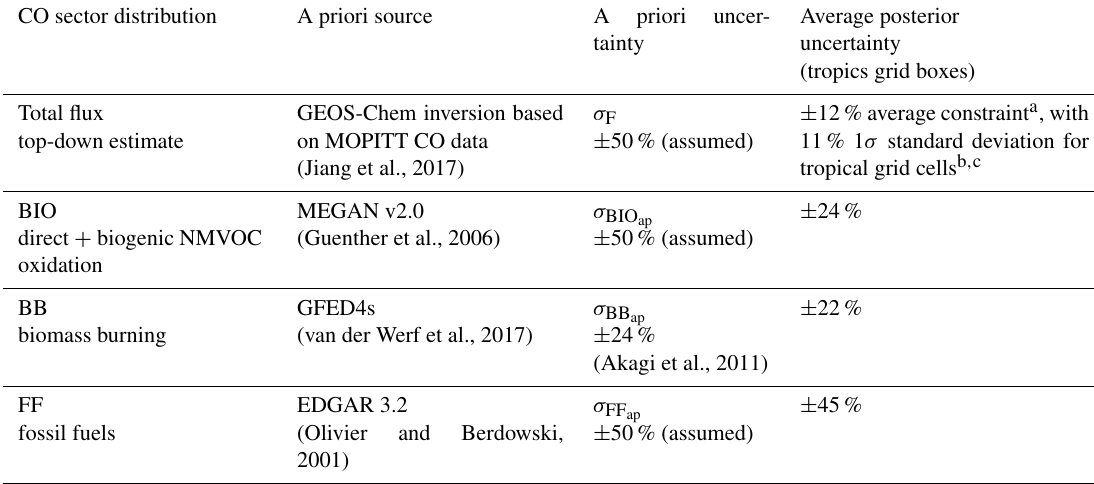
Table 1. Uncertainties applied in the Bayesian source attribution (Eq. 1). Values are monthly averages for single grid boxes (5 ◦ × 4 ◦ longi- tude × latitude) in the tropical study regions.